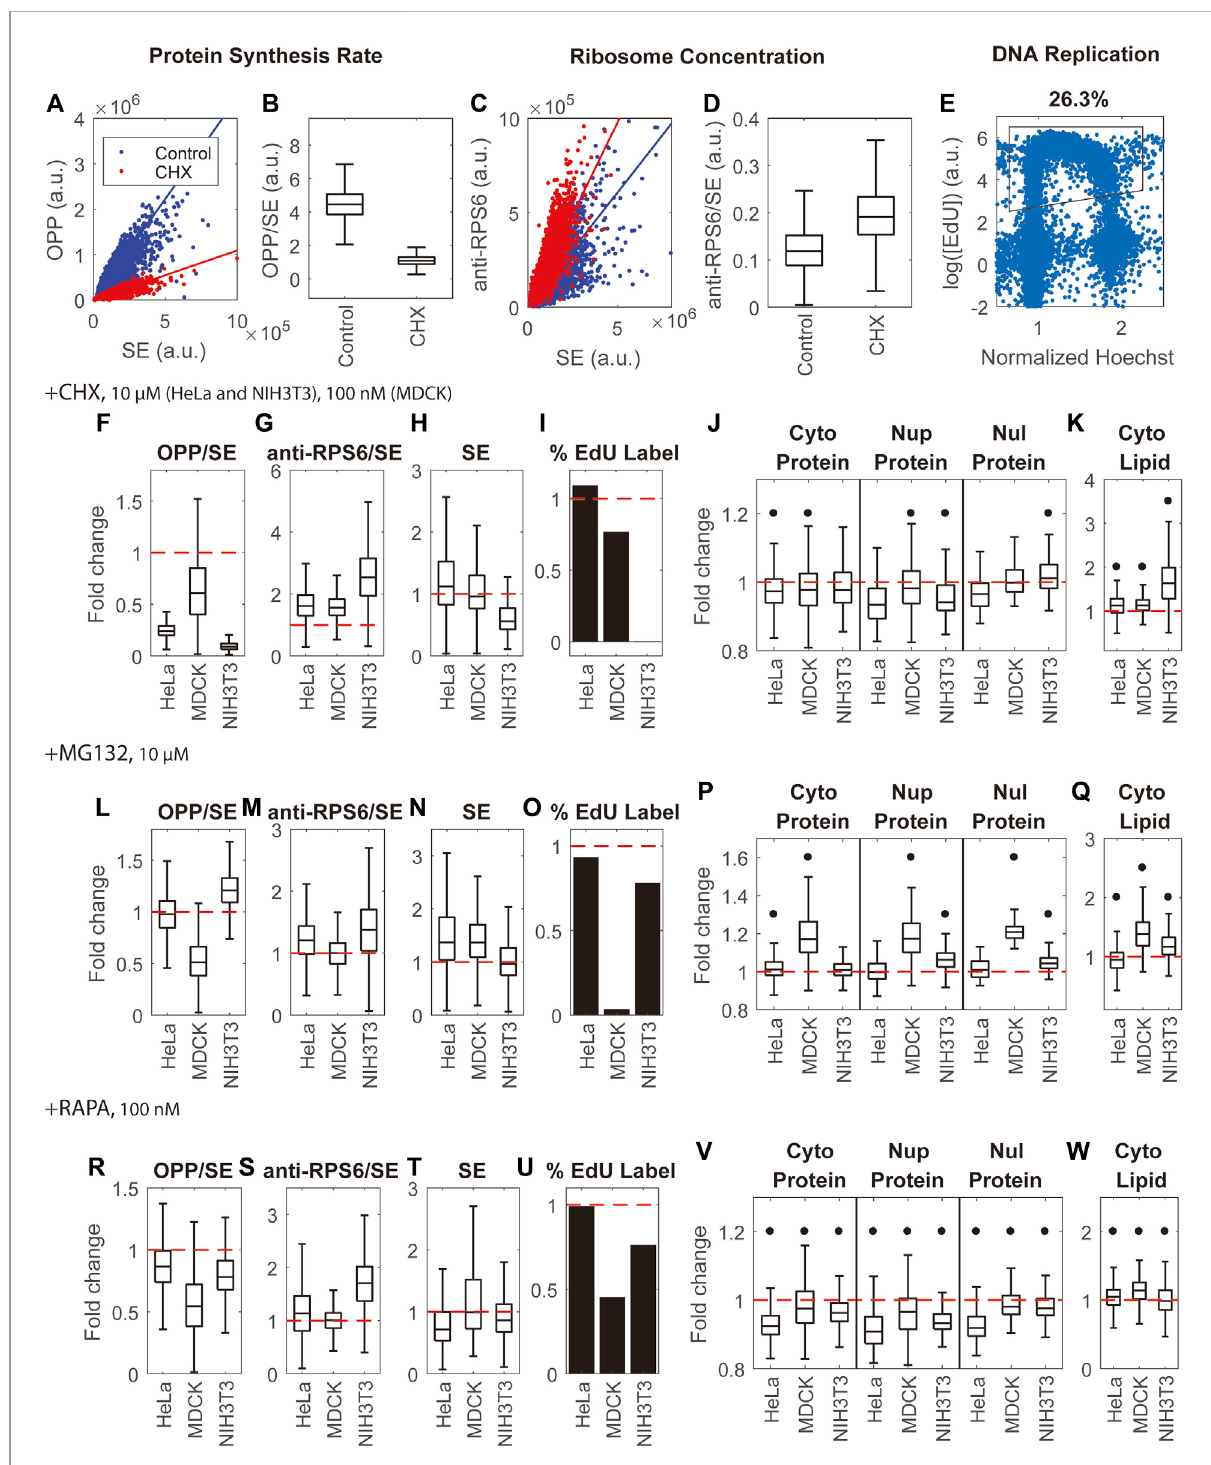
FIGURE 6 Inhibition of protein synthesis, protein degradation, and mTOR activity have little effect on mass density. (A,B) Quanti fi cation of protein synthesis rate by the ratio of OPP pulse label to SE protein stain (OPP/SE) demonstrated by untreated HeLa cells and HeLa cells treated by Cycloheximide(CHX).Solidlinesin (A) arey=kx,wherekisthemedianoftheOPPtoSEratio. (C,D) Quanti fi cationofribosomeconcentrationbythe anti-RPS6immunostaintoSEproteinstainratio(anti-RPS6/SE)demonstratedbyuntreatedHeLacellsandHeLacellstreatedbyCHX.Solidlines in (C) are y = kx, where k is the median ofthe anti-RPS6 to SE ratio. (E) Quanti fi cation ofDNAreplication byEdU labeling inuntreated HeLa cells. The